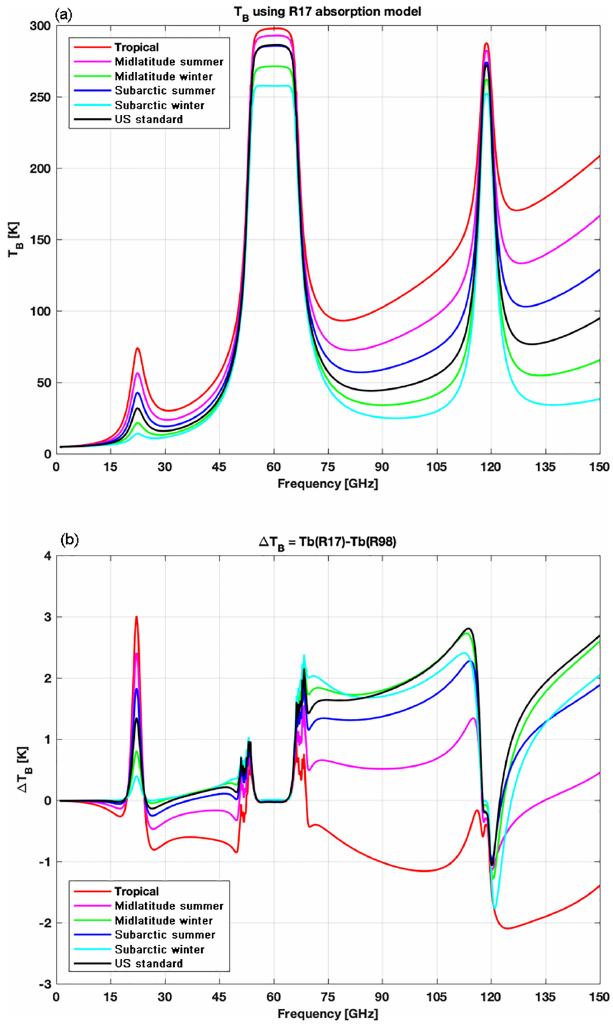
Figure 1. (a) Zenith downwelling T B computed using six reference atmosphere climatology conditions with the R17 model. (b) Differ- ence between T B computed with the current and reference versions (R17 minus R98) for the six atmosphere climatology conditions. This figure is similar to Fig. 1 in Cimini et al. (2018), although T B were recomputed to cover a wider frequency